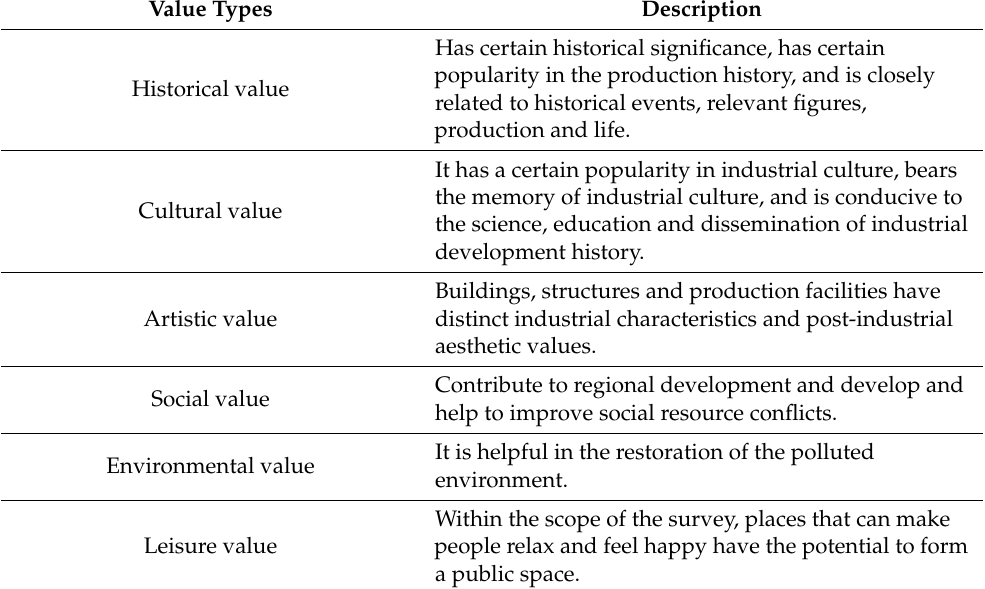
Table 1. The description of brownfield landscape value and brownfield redevelopment